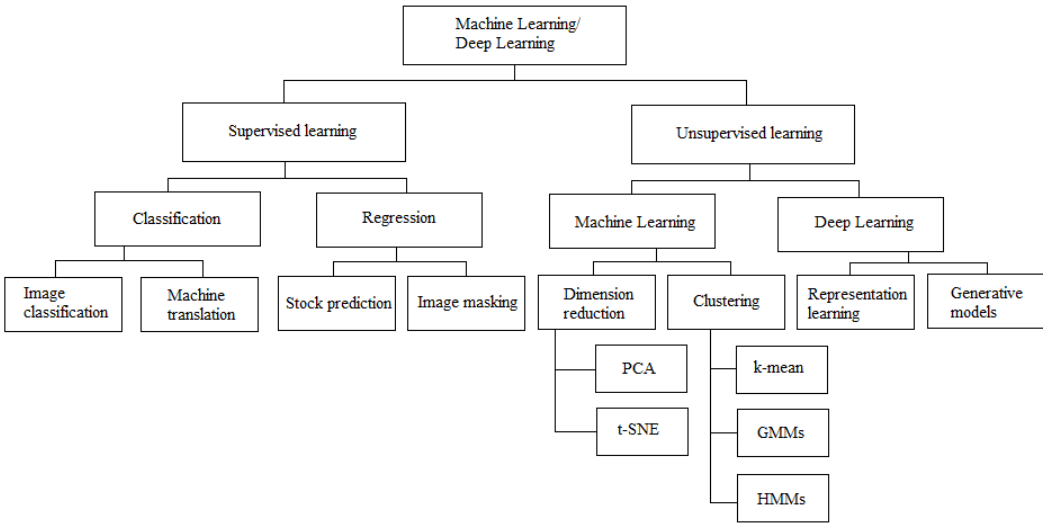
Figure 6. Overview and classification of various machine learning (ML) and deep learning (DL) techniques. (Shukla, et al. (2020) [159]).